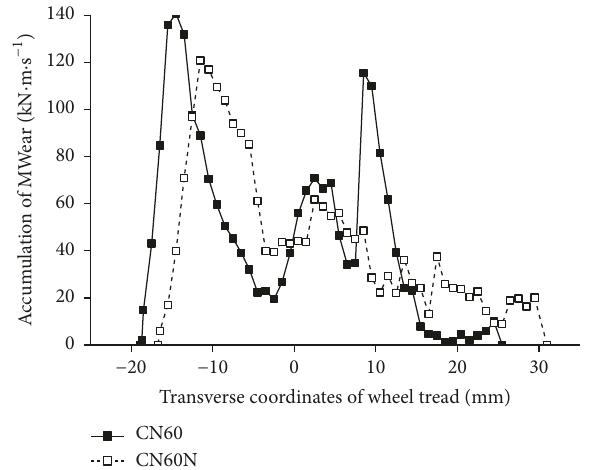
Figure 14: Cumulative wear power dissipation (S1002CN tread matched with the different rail